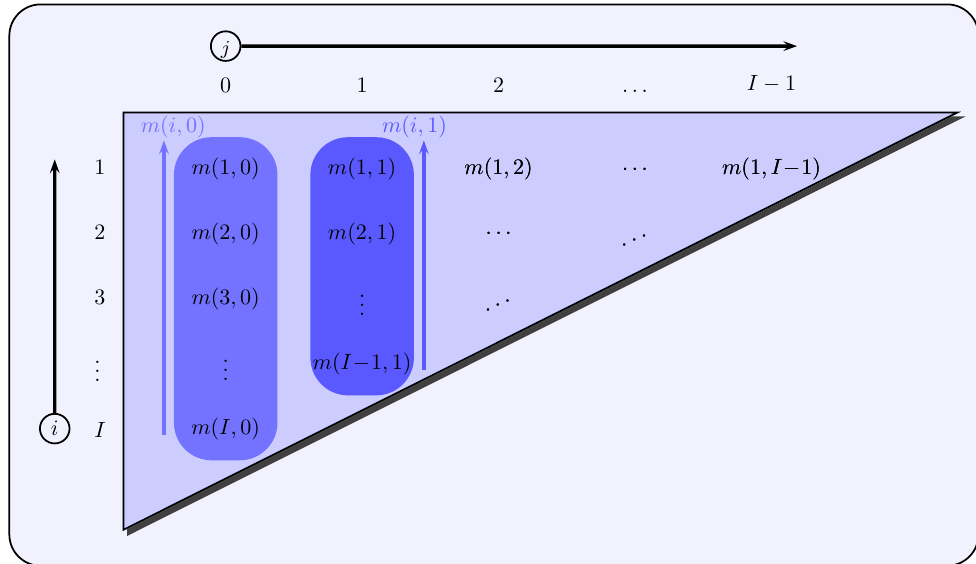
Figure 3. Sequences m ( i , j ) for a given development year j